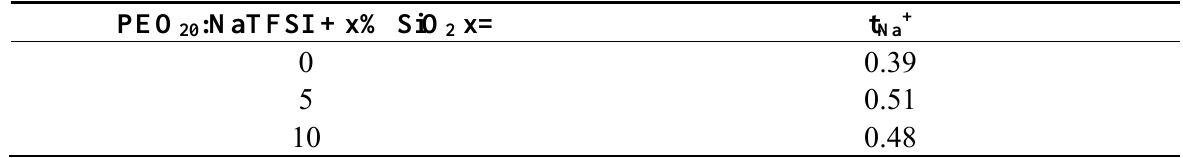
Table 1. Transference number for PEO 20 :NaTFSI + x% SiO 2 ; x = 0, 5, 10.